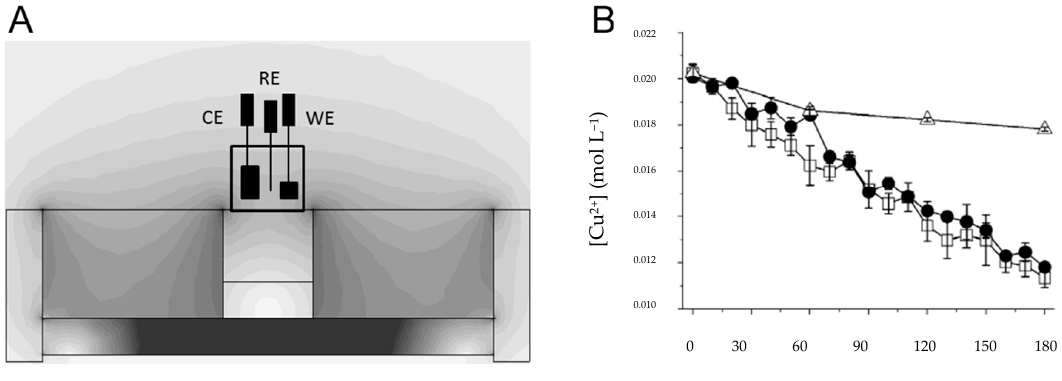
Figure 7. ( A ) Simulated magnetic field profile of the home-built unilateral NMR sensor. The simulation procedure was performed without the electrochemical cell on unilateral probe. The gray color scale represents the magnetic field from 0.05 to 1.0 T. Each color scale is equivalent to 0.05 T. ( B ) Variation of the Cu 2 + concentration during the electrodeposition reaction measured by CPMG pulse sequence under different configurations: B = 0 ( △ ), B ⊥ j ( ◻ ) and B ∥ j ( ● ). E applied = − 0.5 V vs. Ag wire. T = 25 ± 1 ○ C. The error bars were calculated from three replicates. Adapted from Publication [9], Copyright (2015), with permission from